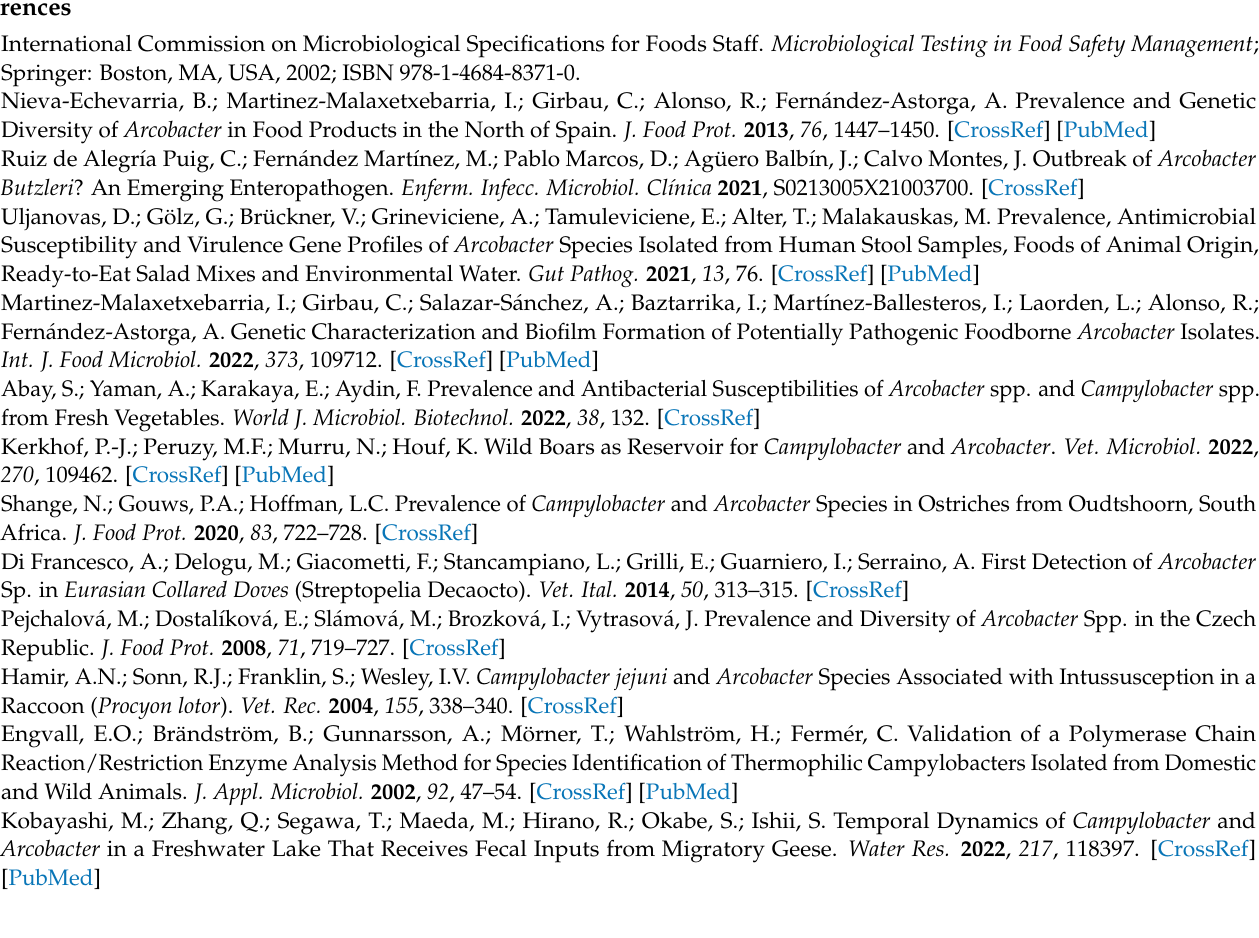
Figure S1: Growth curves of wild-type and mutant strains and their growth rates, Figure S2: Motility of the different wild and knockout strains, Figure S3: Colony growth pigmentation in CRA assay of the different wild and knockout